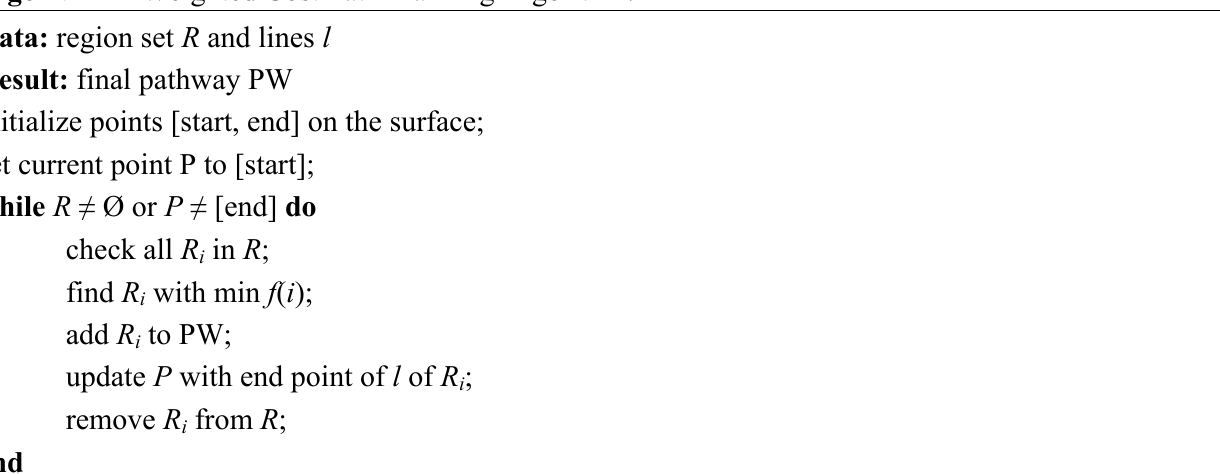
Algorithm 2 Weighted Cost Path Planning